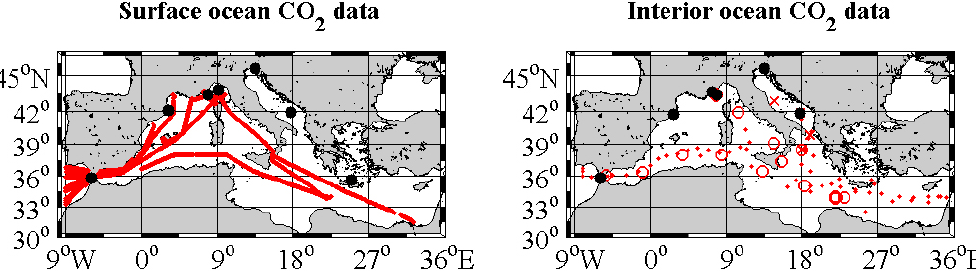
Fig. 19. Mediterranean Sea CO 2 data available in public databases. Left panel: p CO 2 data (surface ocean) from the SOCATv2 database (red dots), and time-series stations with p CO 2 data (black dots). Right panel: DIC data from the interior ocean; red dots Meteor cruises M51 and M84/3 in 2001 and 2011, red crosses MATER cruises from 1997 and 1998, red circles the PROSOPE cruise, black dots the time-series stations. The data from all time-series stations are not publicly available at this